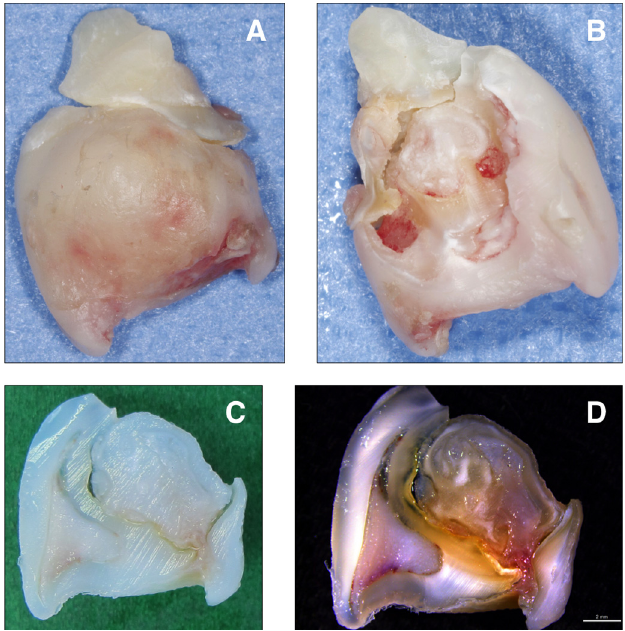
Fig. 5. Macroscopic view of the lesion. (A) Labial surface. (B) Lingual surface. (C) Sliced surface. (D) Sliced surface photographed in white light. A mass of enamel-like mineralized calci fi cations, dentin-like mineralized tissue and non-mineralized pulpal-type tissue is included in a better organized dental structure with enamel covering a dentine tissue and a pulp tissue. Scale bar: 2 mm.